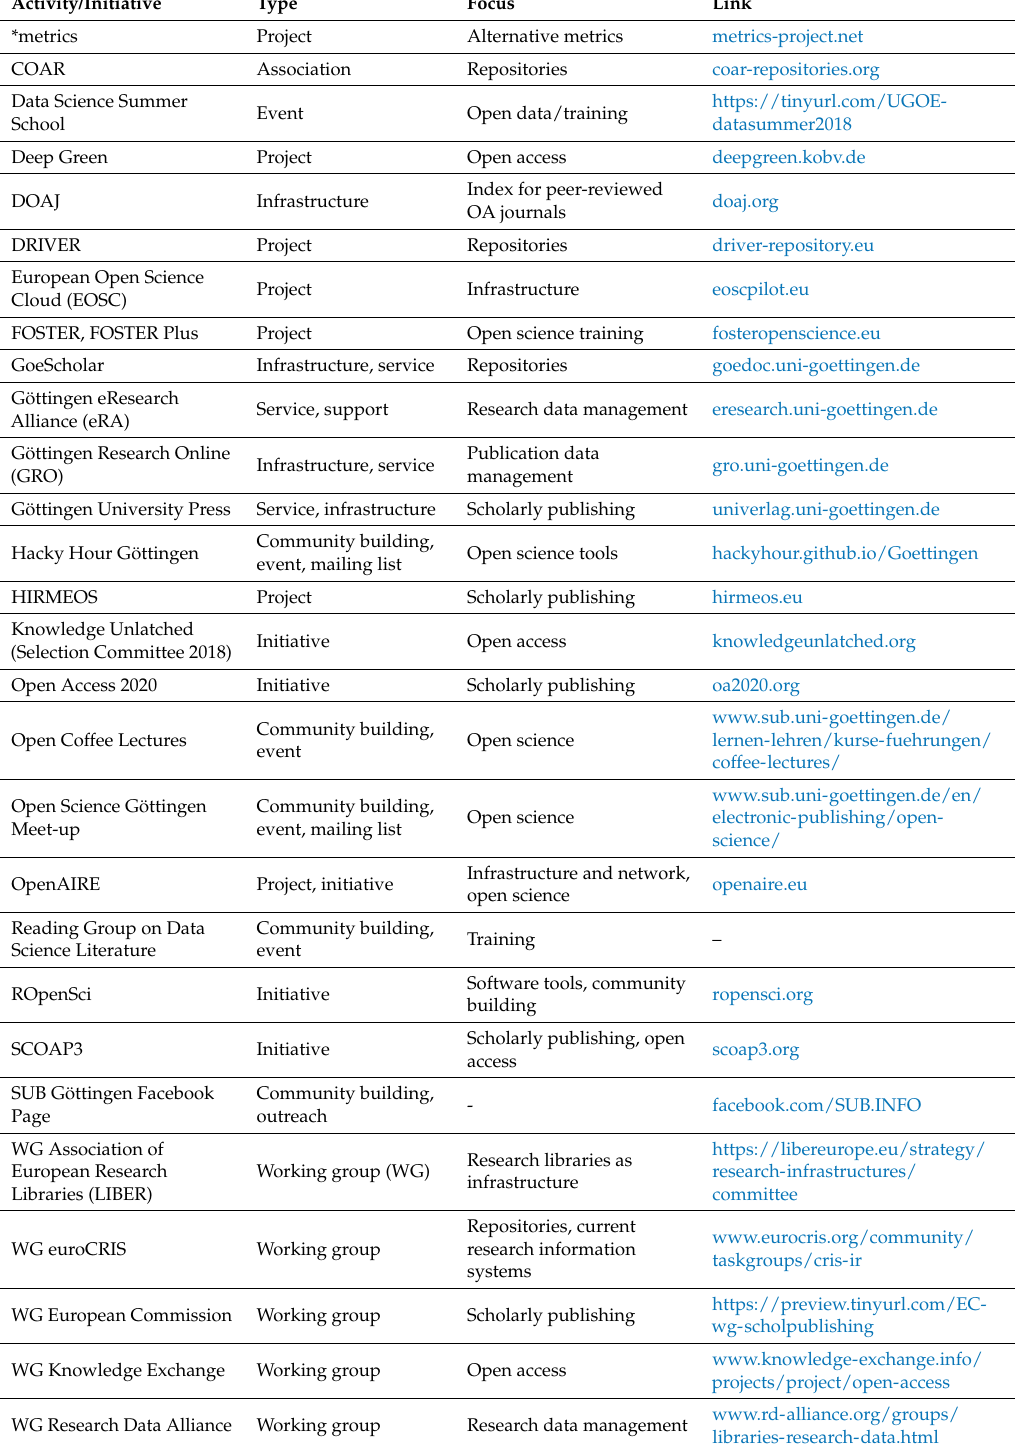
Table 1. Overview of mentioned open science projects and